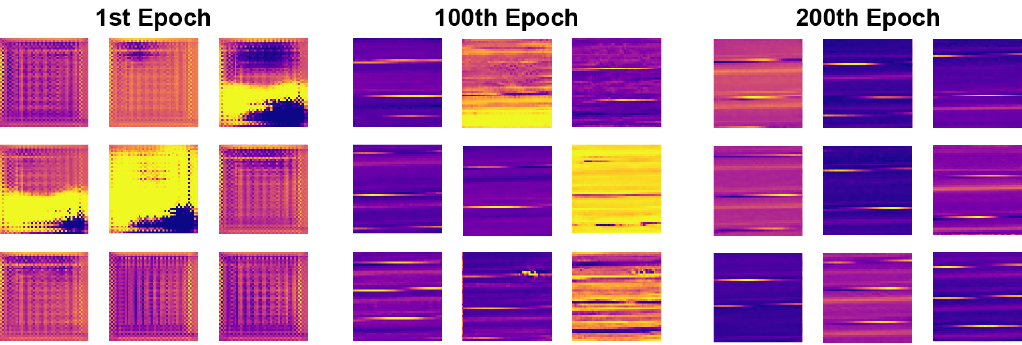
Figure 7. Generated Cardiogram images samples through 200 epoch training with a CNN